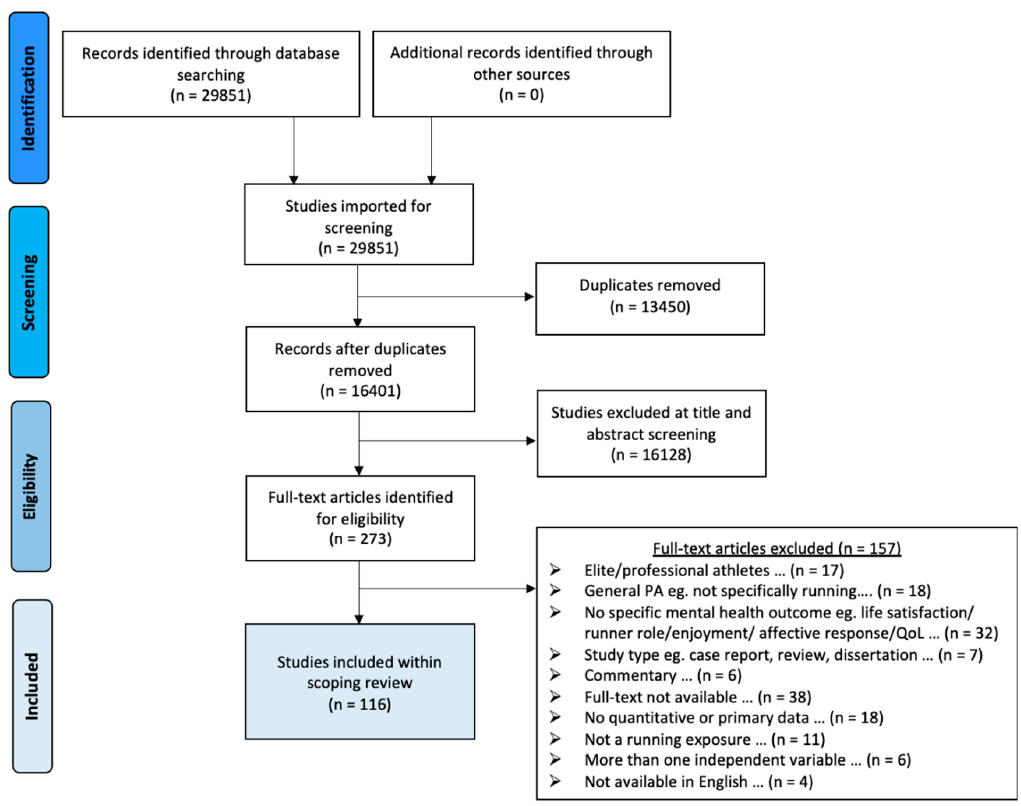
Figure 1. Preferred Reporting Items for Systematic Reviews and Meta-Analyses (PRISMA) depicting the identification, screening, eligibility and inclusions of texts within the scoping review.